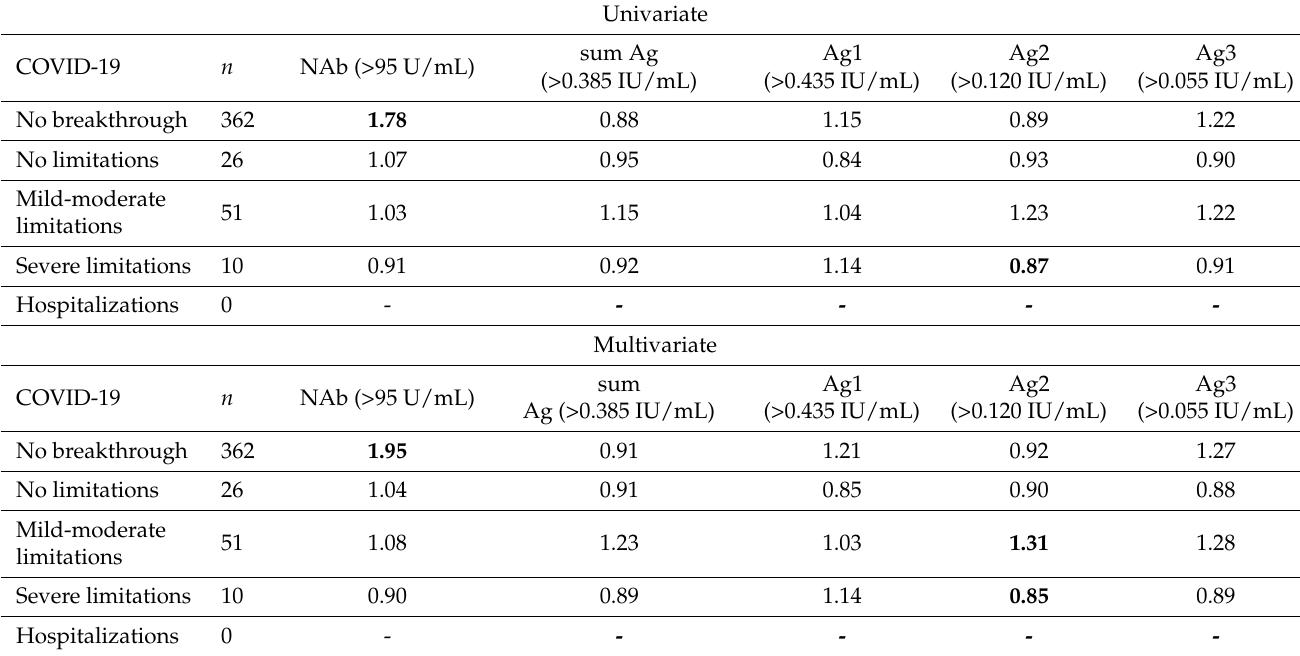
Table 3. Risk of breakthrough infections using thresholds chosen based on ROC analysis.